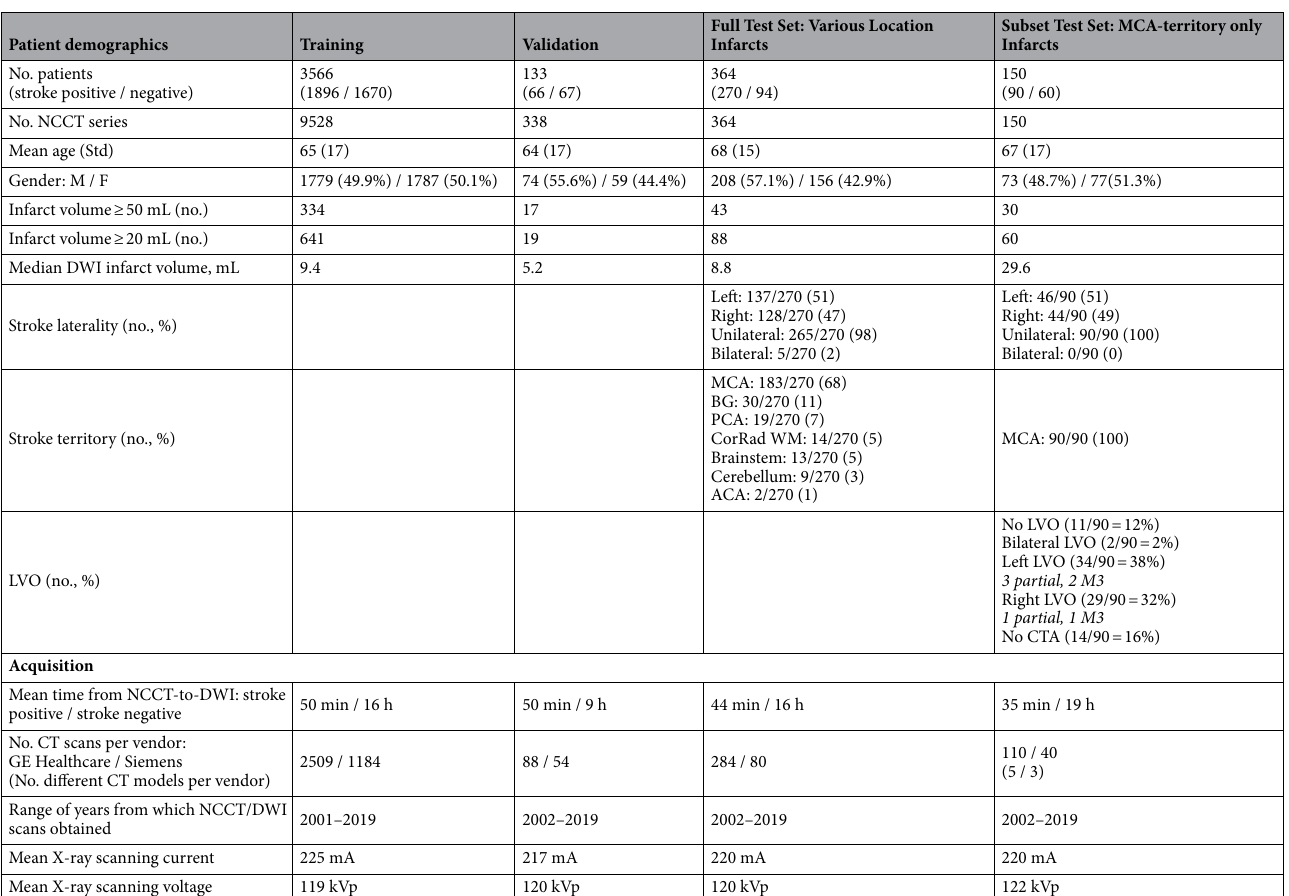
Table 1. Dataset description with patient demographics and acquisition details. (Legend: no. = number, Std = standard deviation, M/F = male/female, IQR = inter-quartile range, mAs = milliampere-seconds, kVp = kilovoltage peak, MCA = middle cerebral artery, BG = basal ganglia, PCA = posterior cerebral artery, CorRad WM = corona radiata white matter, and ACA = anterior cerebral artery, LVO = large vessel occlusion [ICA, M1,